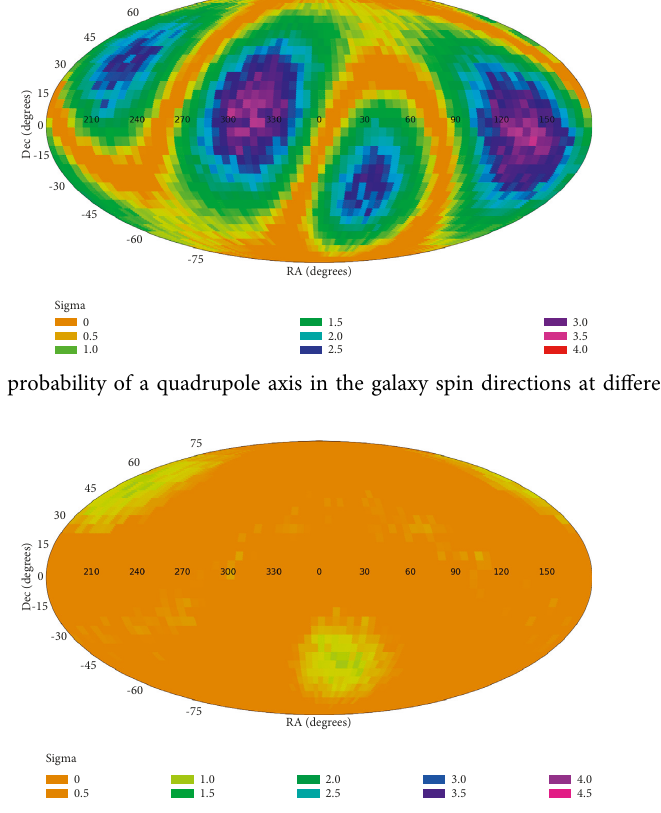
Figure 8: The probability of a quadrupole axis in the galaxy spin directions when the galaxies are assigned with random spin directions.